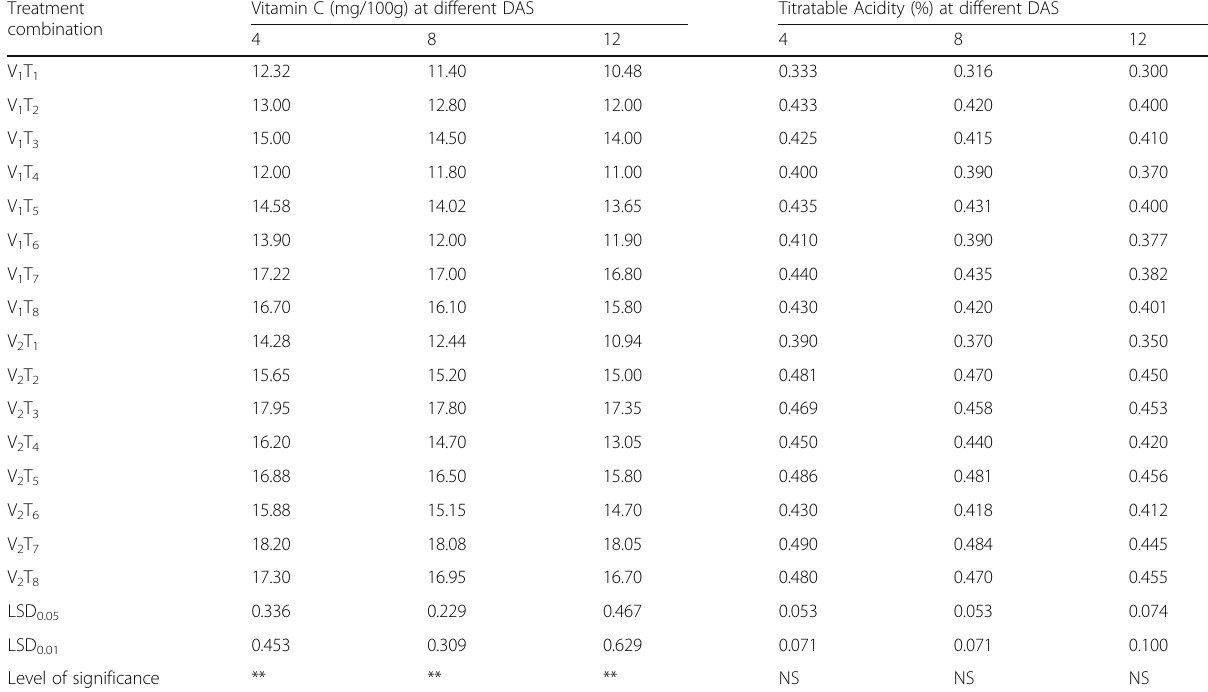
Table 9 Combined effect of varieties and different postharvest treatments on vitamin C content and titratable acidity of tomato Treatment